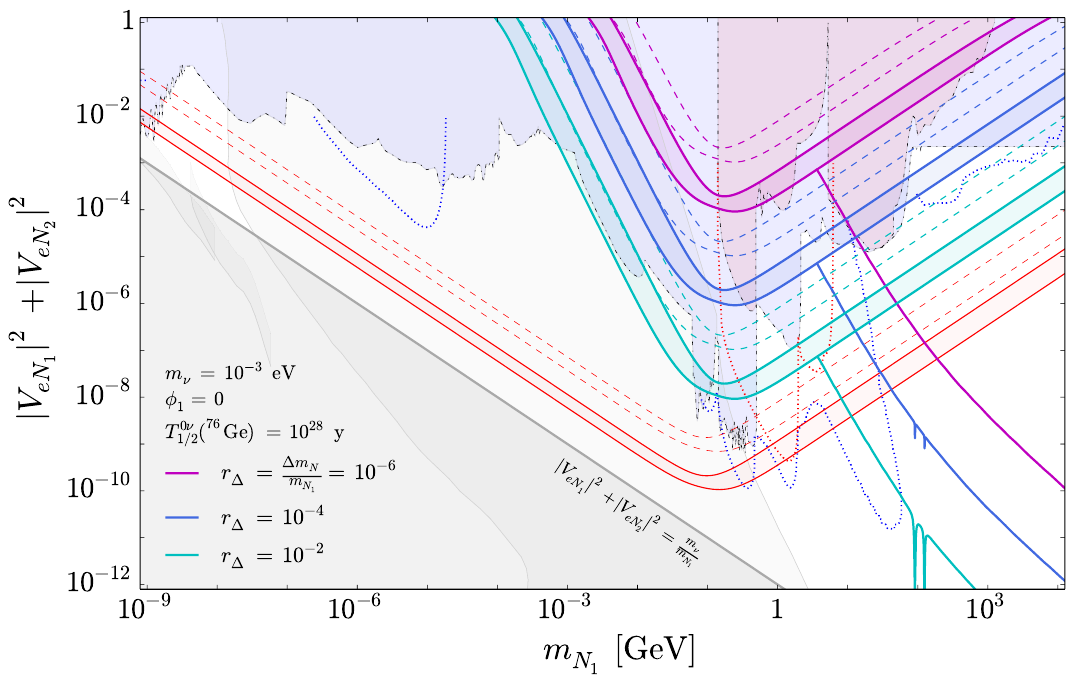
Figure 10 . As (cid:12)gure 9, but showing the future 0 (cid:23)(cid:12)(cid:12) decay sensitivity for 76 Ge at T 0 (cid:23)